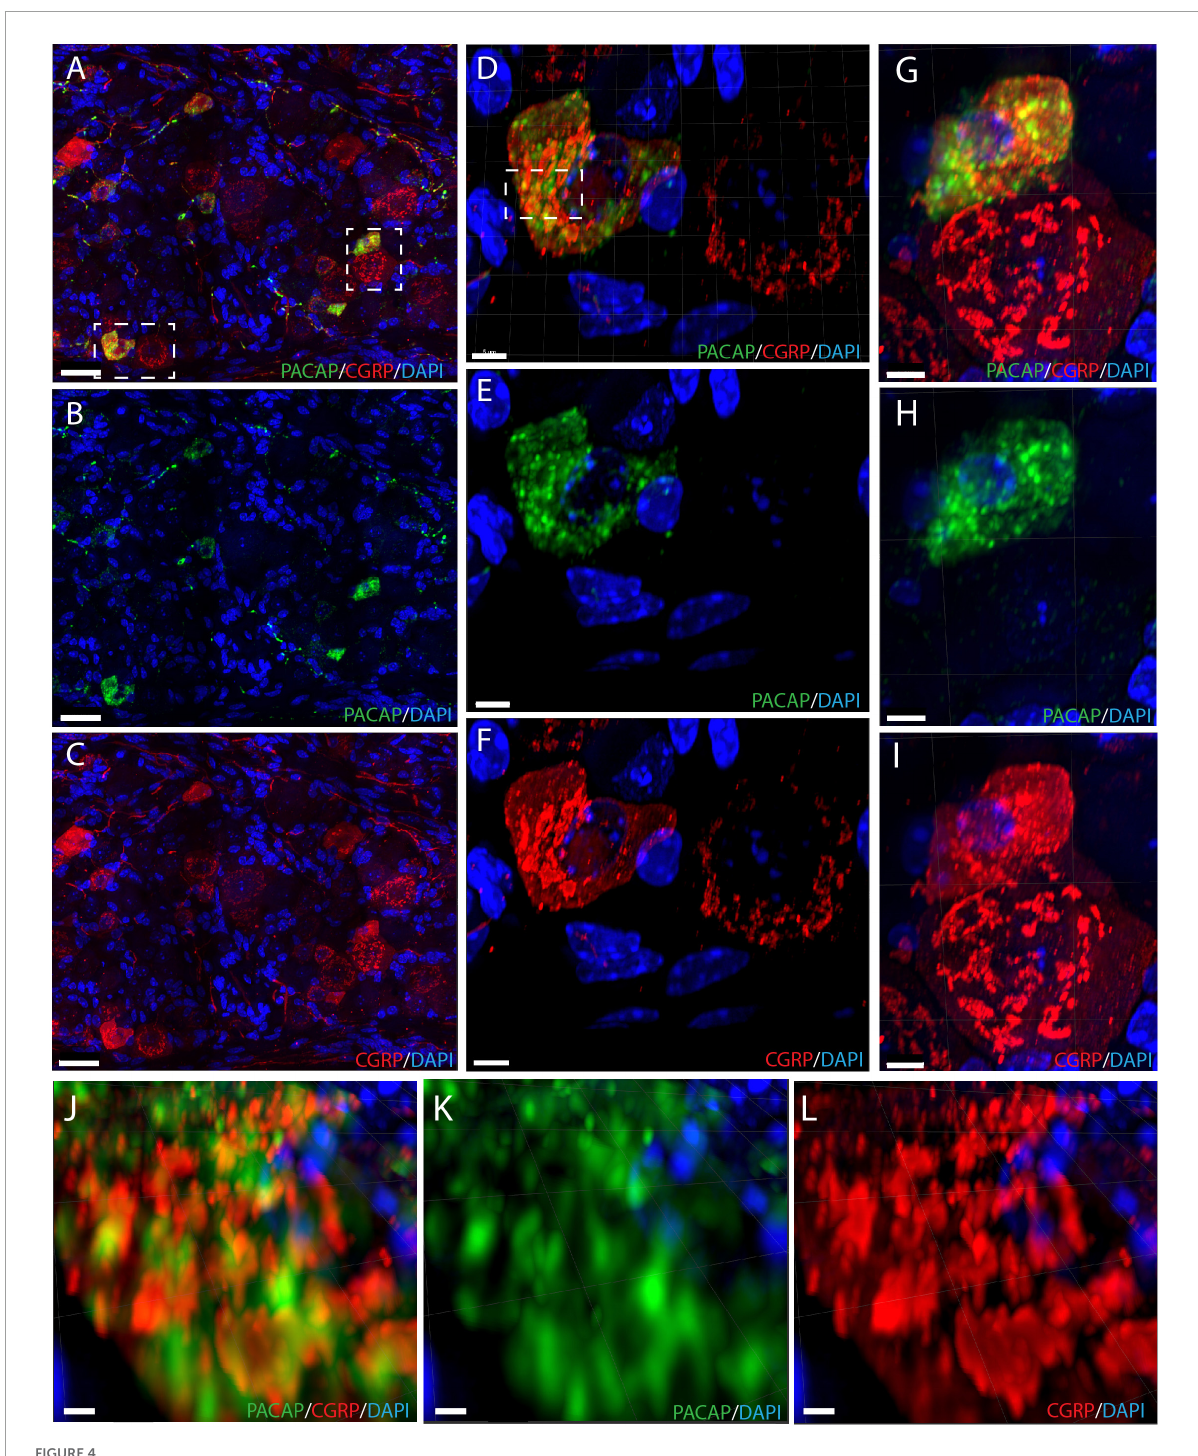
FIGURE4 Immunostaining showing neuronal somas with intracellular components in the trigeminal ganglion (A–C) with PACAP (green) and CGRP (red). Double immunostaining in panel (A) , PACAP (B) , and CGRP (C) . The left dashed box in panel (A) is magnified in panels (D–F) and shows a cell with colocalized neuropeptides and a CGRP-positive cell. Double immunostaining is seen in panel (D) , PACAP (E) , and CGRP (F) . The right dashed box in panel (A) is magnified in panels (G–I) and illustrates another colocalized cell and a CGRP-positive cell with double immunostaining (G) , PACAP (H) , and CGRP (I) . The dashed box in panel (D) is magnified in panels (J–L) illustrating distinct secretory granules containing either PACAP or CGRP in a cell with colocalization. Double immunostaining in panel (J) , PACAP (K) , and CGRP (L) . Scale bars (A–C) = 30 µ m, (D–I) = 5 µ m, (J–L) = 2 µ